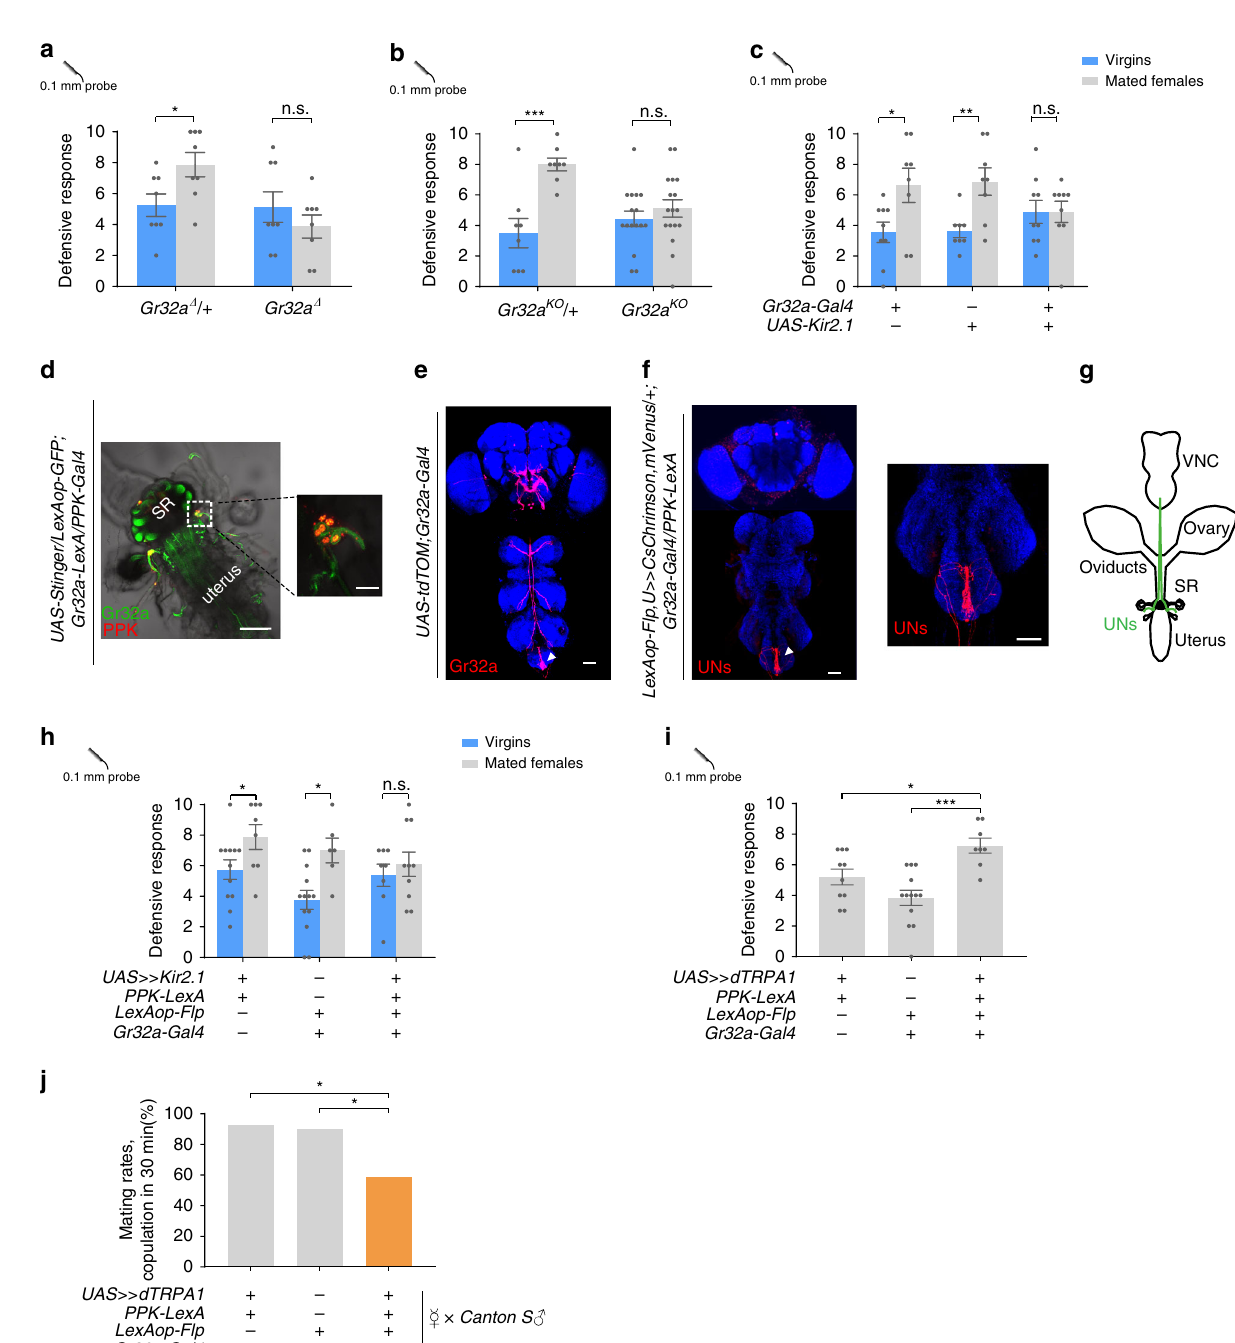
Fig. 4 Gr32a uterine neurons (UNs) mediate post-mating switch of defensive response. a , b Two mutant alleles of Gr32a , Gr32a Δ (a), and Gr32a KO (b), failed to show the increase defense after mating. n = 8 for each group in ( a ), n = 8, 8, 16 and 17 (from left to right) in ( b ). *** p < 0.001, * p < 0.05, p > 0.05 (n.s.), two-tailed unpaired t tests. c Silencing Gr32a neurons with Kir2.1 eliminated the mating-induced elevation of defensive response. n = 9, 8, 8, 8, 9, and 9 (from left to right). ** p < 0.01, * p < 0.05, p > 0.05 (n.s.), two-tailed unpaired t tests. d Co-expression of PPK (red) and Gr32a (green) in female reproductive tract. Scale bar represented 50 μ m. Right: the cell bodies of PPK (red) and Gr32a (green) on uterus were enlarged. SR indicated seminal receptacle. Scale bar represented 20 μ m. e Immuno fl uorescence of Gr32a (red) in the central nervous system. White arrow indicated projections of Gr32a neurons on the uterus. Blue: nc82. Scale bar represented 50 μ m. f Immuno fl uorescence of UNs (red). The expression of Gr32a in chemoreceptors on other appendages was eliminated by intersection strategy of indicated genotype. White arrow indicated projections of Gr32a UNs. Right panel: projections of UNs in the Abg. Blue: nc82. Scale bar represented 50 μ m. g Schematic showed that the cell bodies of UNs. These UNs projected to the abdominal ganglion of the VNC (green). h , i Silencing UNs h blocked the post-mating enhancement of defensive response, while activating them i elevated defensive response in decapitated virgins. n = 12, 8, 13, 6, 8, 10 (from left to right) in (h), n = 10, 13, 8 for each group in (i). *** p < 0.001, * p < 0.05, p > 0.05 (n.s.), two-tailed unpaired t tests. j Activation of UNs in virgin females decreased the courtship successful rates, and these virgins were paired with naïve Canton S male. n = 14, 20 and 17 for each group. * p < 0.03, two-tailed Fisher ’ s exact test. Error bars indicate mean ± SEM, n.s., not signi fi cant. Source data are provided as a Source Data fi